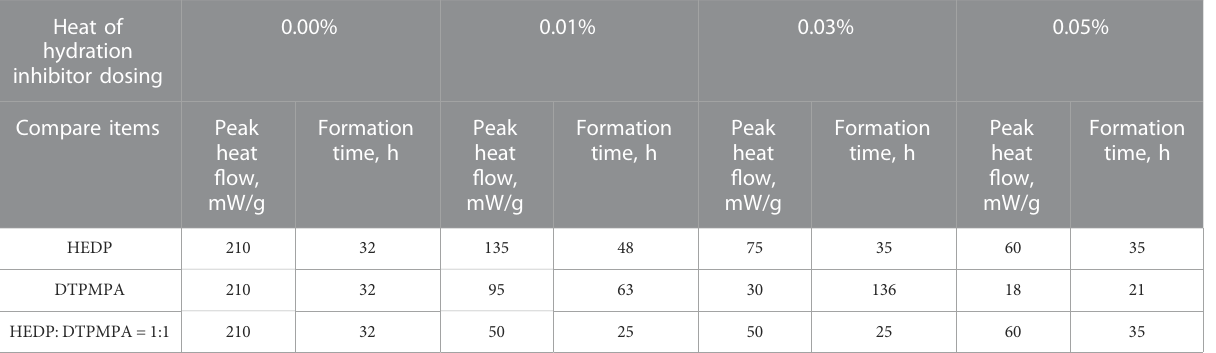
TABLE 9 Heat release rate data for the OPC hydration